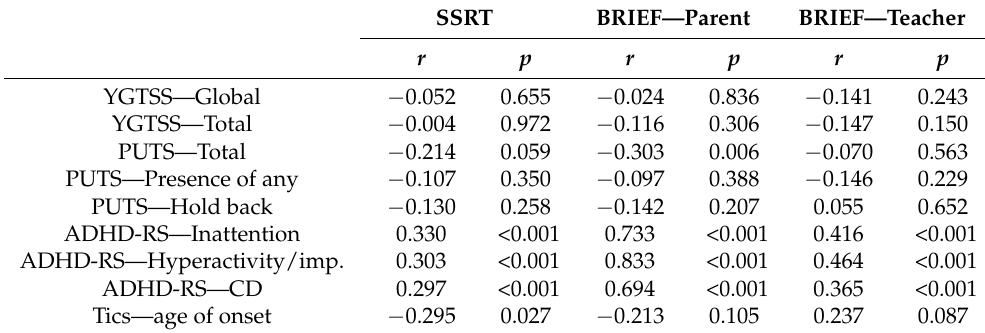
Table 4. Correlations between inhibitory control and symptom